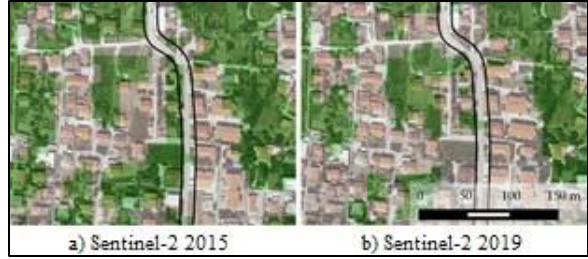
Figure 10. A closer look at classification results in the residential area - green areas show land under vegetation